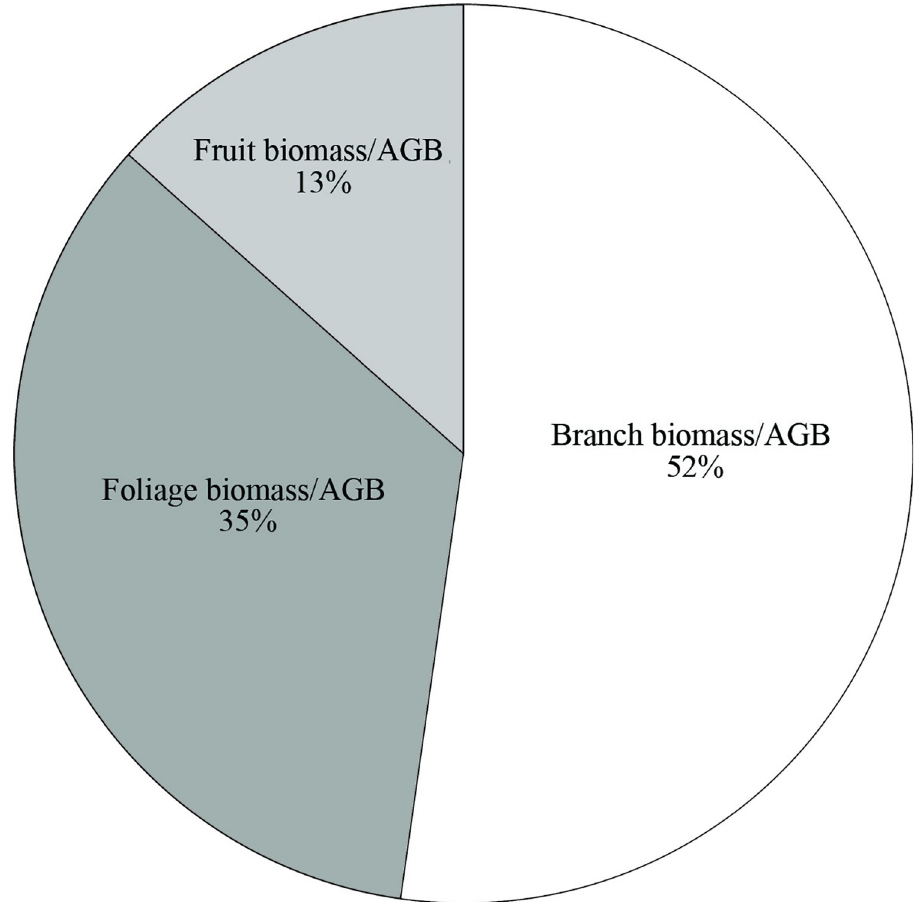
Fig 2. Biomass partitioning of the above-ground components of Nitraria sibirica